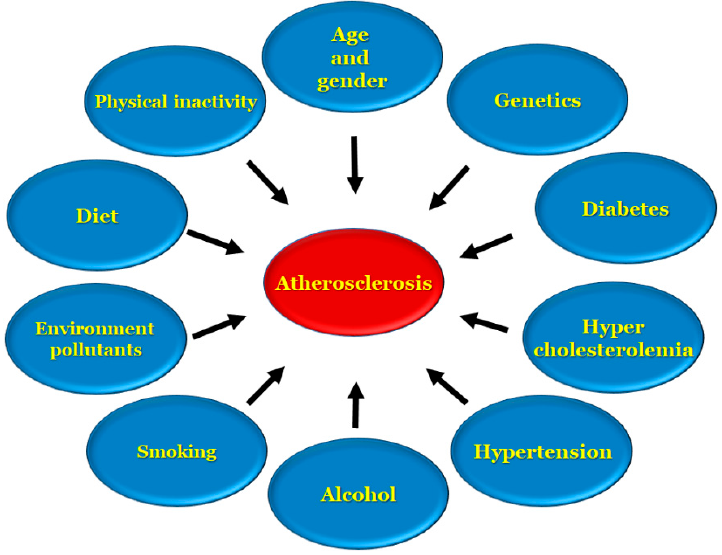
Figure 1. Risk factors associated with atherosclerosis.